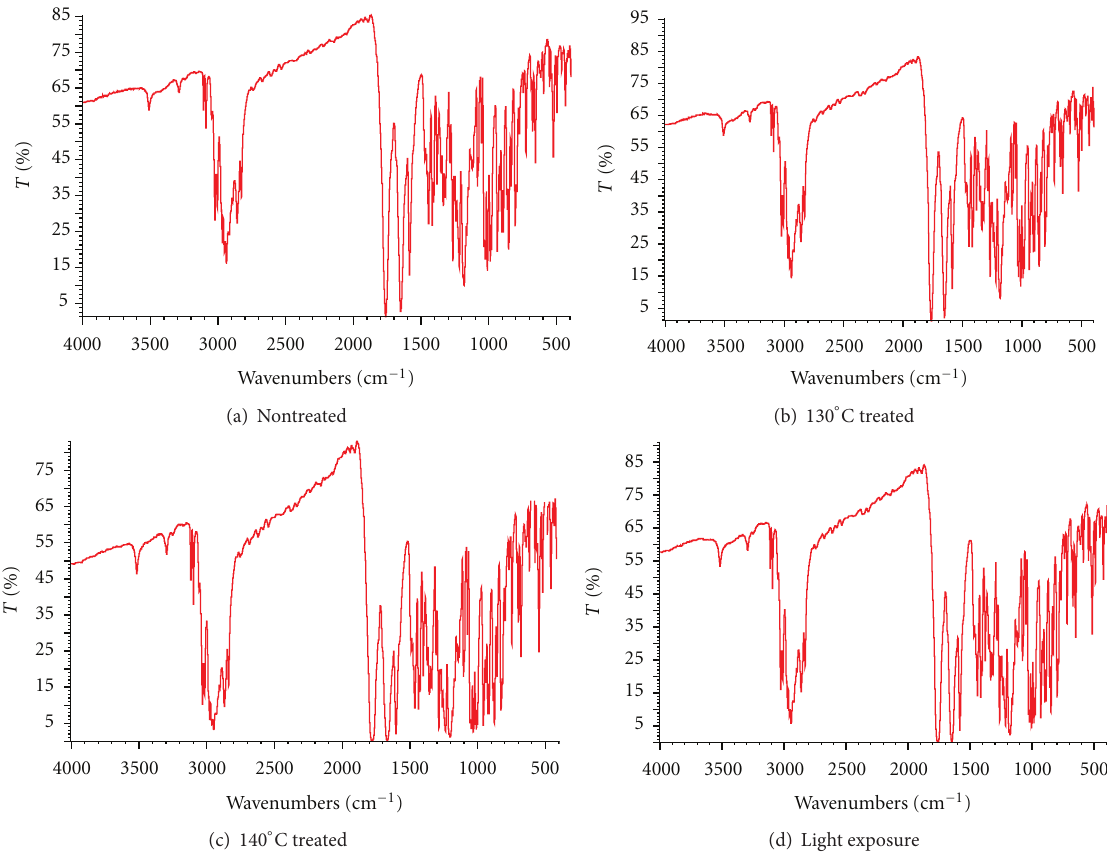
F 4: Infrared radiation scanning pattern of drospirenone compared nontreated with treated.